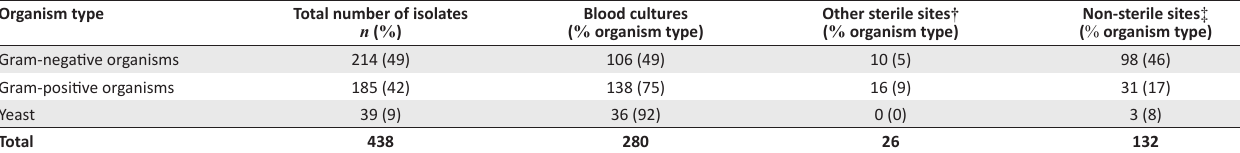
TABLE 1: Organism distribution and site. Organism type